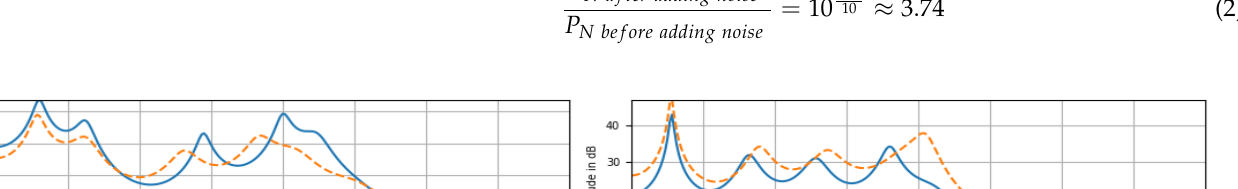
speech. Higher formants are involved in creating the tone of the voice. So, it can be seen waveform and average signal ‐ to ‐ noise ratio before and after noise addition. The red line that the shifting of formants is mainly for higher ‐ order formants in terms of consequences. is 𝑆/𝑁 average. It can be seen that after adding noise, on average, the 𝑆/𝑁 ratio de ‐